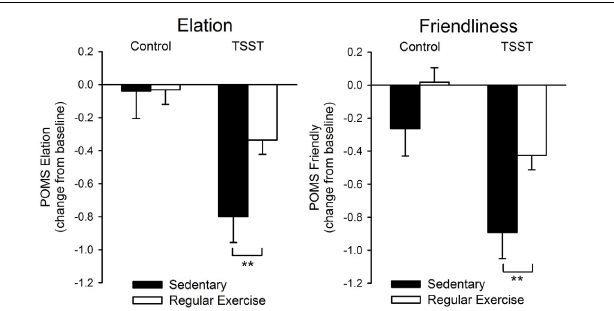
Table 3 | Responses to the control task and TSST among all participants.